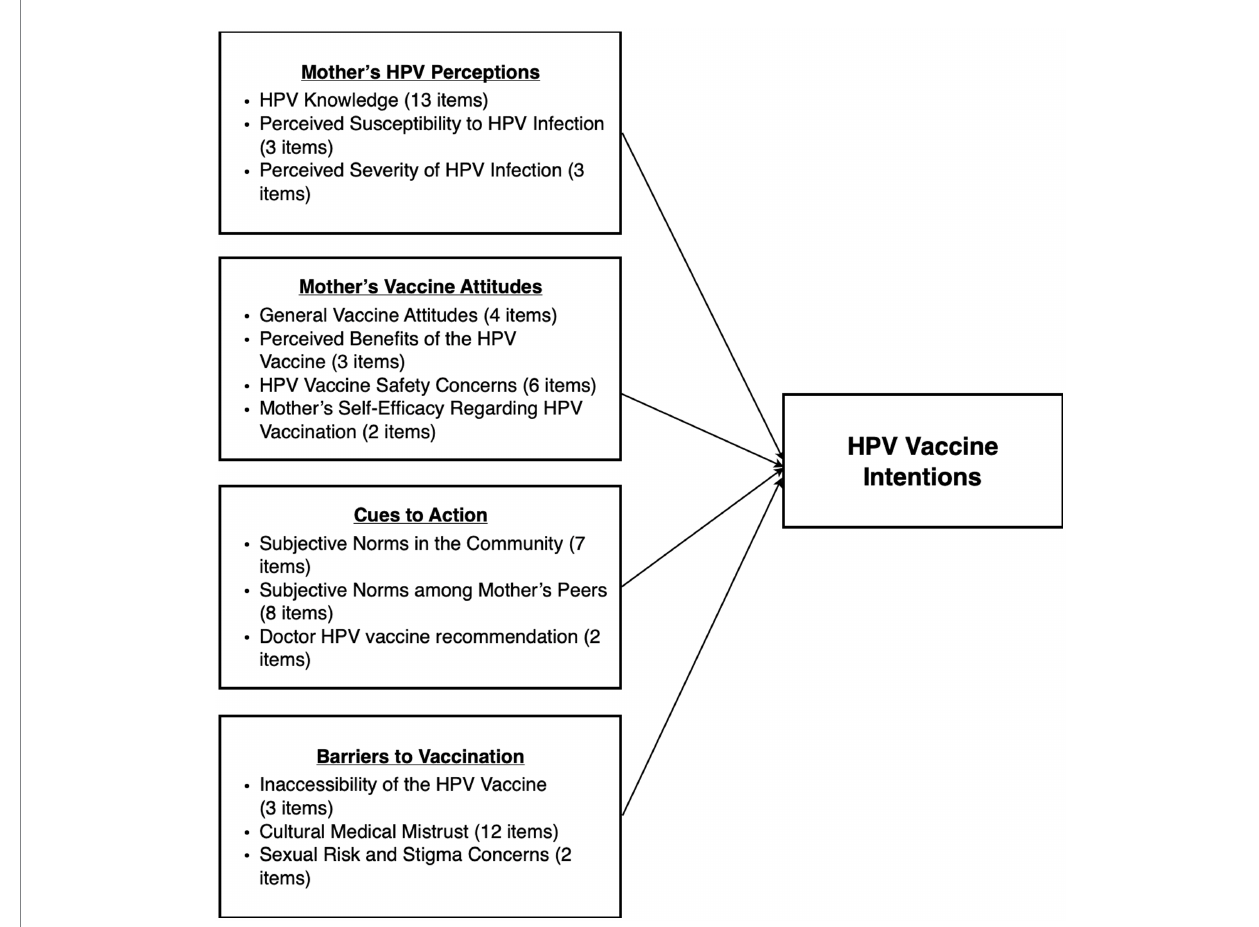
FIGURE 1 Integrated model of psychosocial determinants of HPV vaccination intentions among Black mothers. Culturally informed theoretical model integrating components of the health belief model and the theory of planned behavior as psychosocial determinants of HPV vaccine intentions among Black